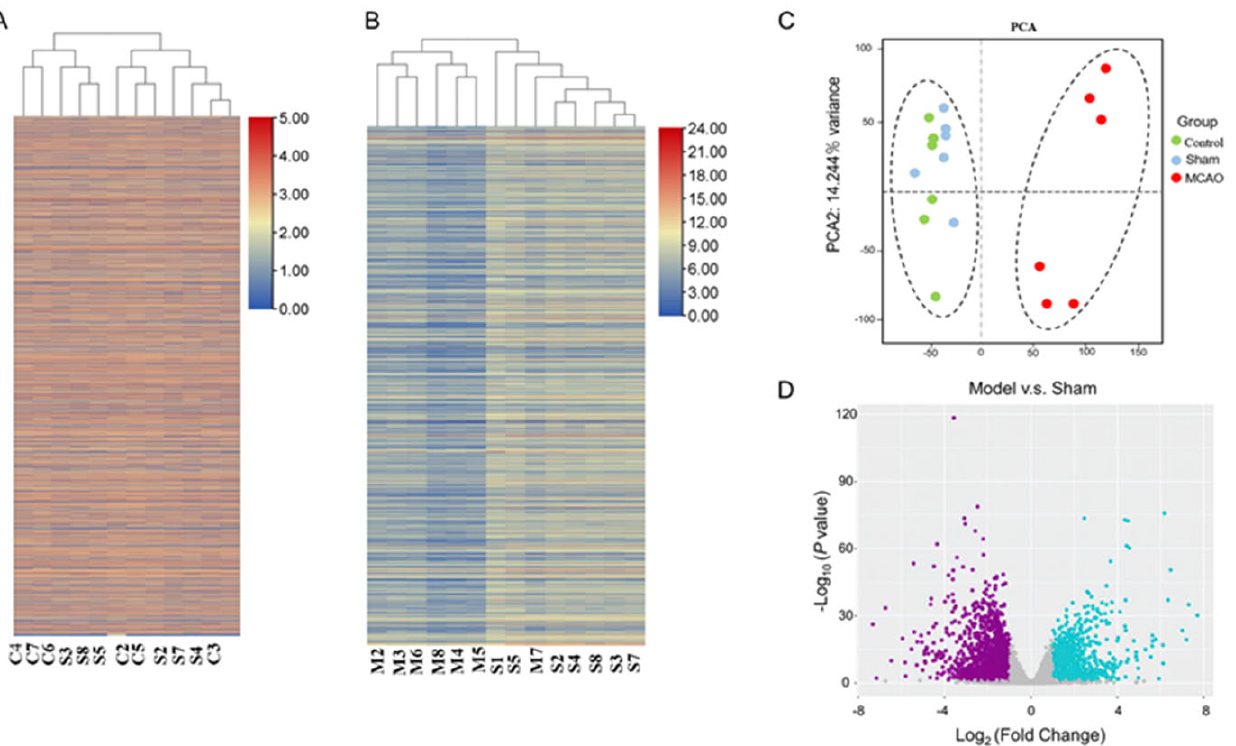
Figure 3. mRNA − seq: differential gene expression analysis ( A , B ) Hierarchical cluster analysis of the significantly upregulated and downregulated mRNAs, each column represented a sample, and each row represented an mRNA. ( C ) PCA analysis of control, sham, and MCAO. ( D ) Volcano plot of differentially expressed genes (DEGs). Blue represents up-regulated genes, Purple represents down-regulated genes, and gray dots represent nonsignificantly DEGs.